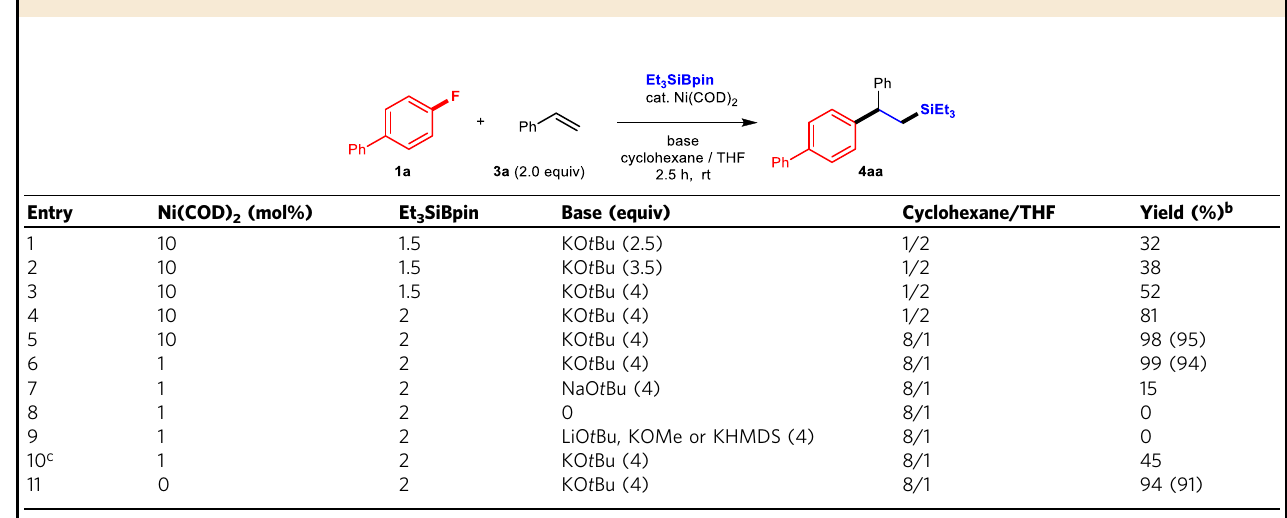
Table 1 Optimization of the reaction conditions. a